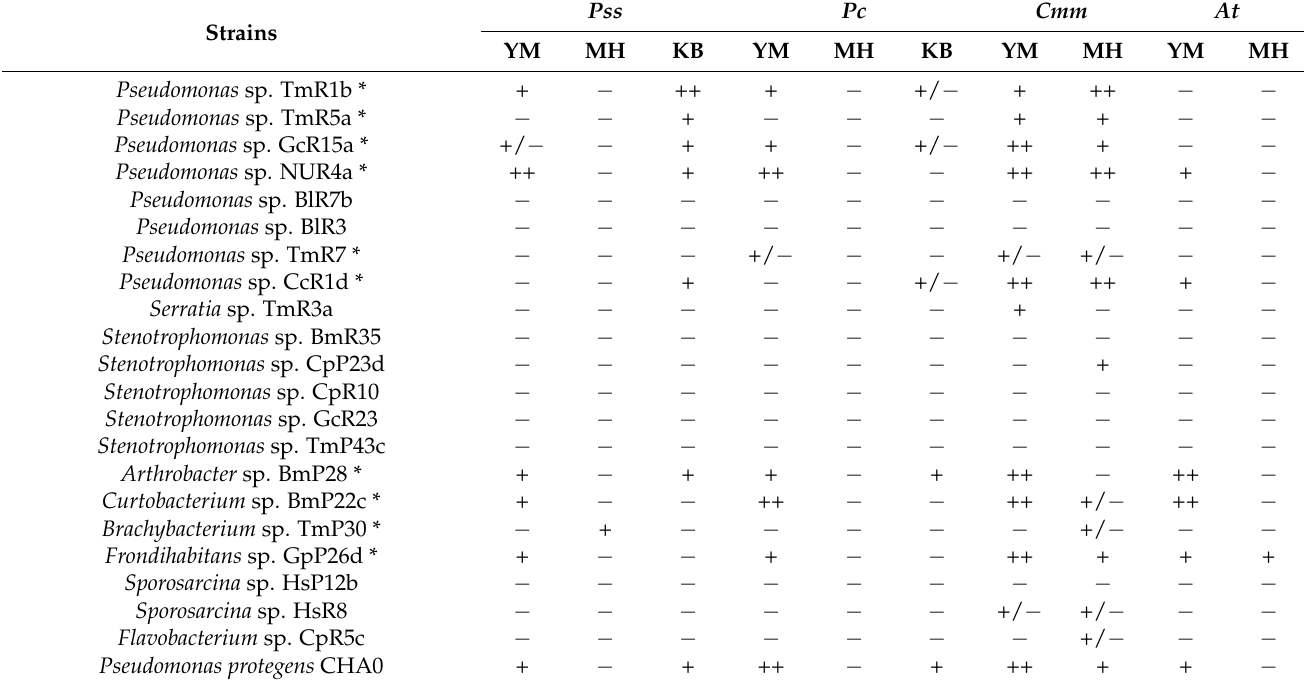
Table 4. Antagonistic activity against phytopathogenic bacteria by the radial streak method.